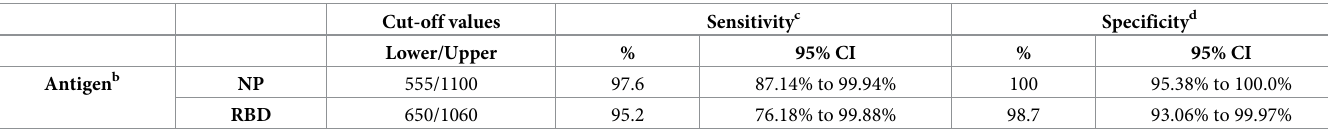
Table 3. Sensitivity and specificity for the IgG COVID-19 multiplex assay a